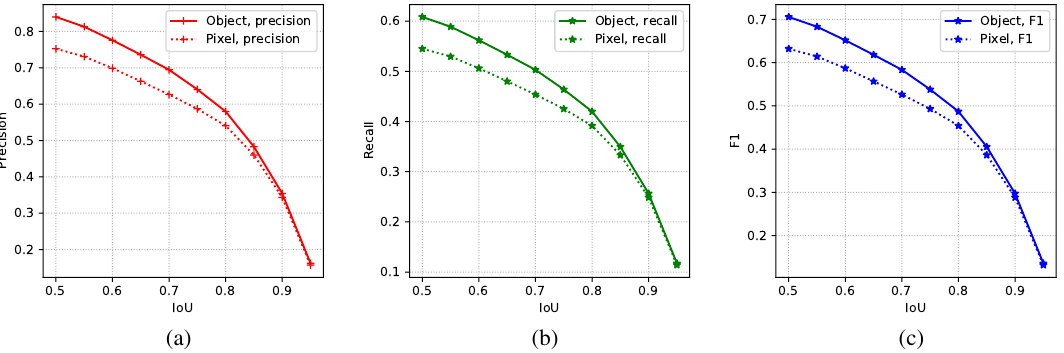
Figure 9. Panel (a) shows evaluations at different IoU scores for the precision, for both the object-level evaluation (solid line) and the pixel-based evaluation (dashed line). Panel (b) shows the recall of the model, with the same style as panel (a). Panel (c) shows the same for the F1 score. Global metrics Precision Recall F1 Evaluation AR AP AF1